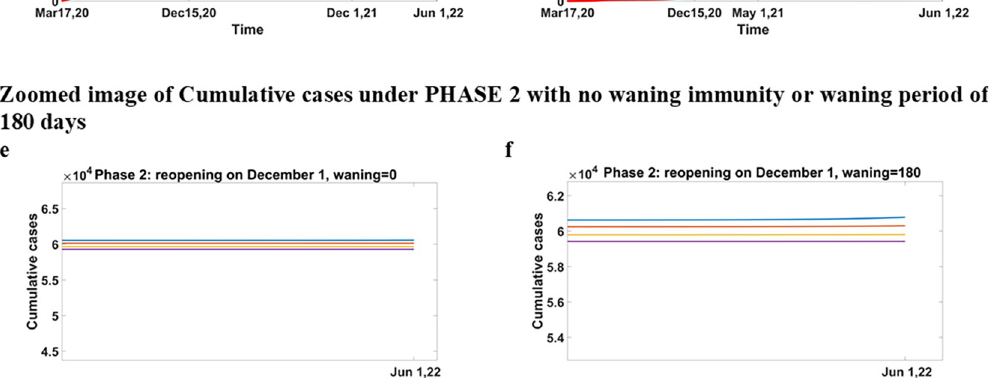
PLOS ONE | https://doi.org/10.1371/journal.pone.0258648 October 27,